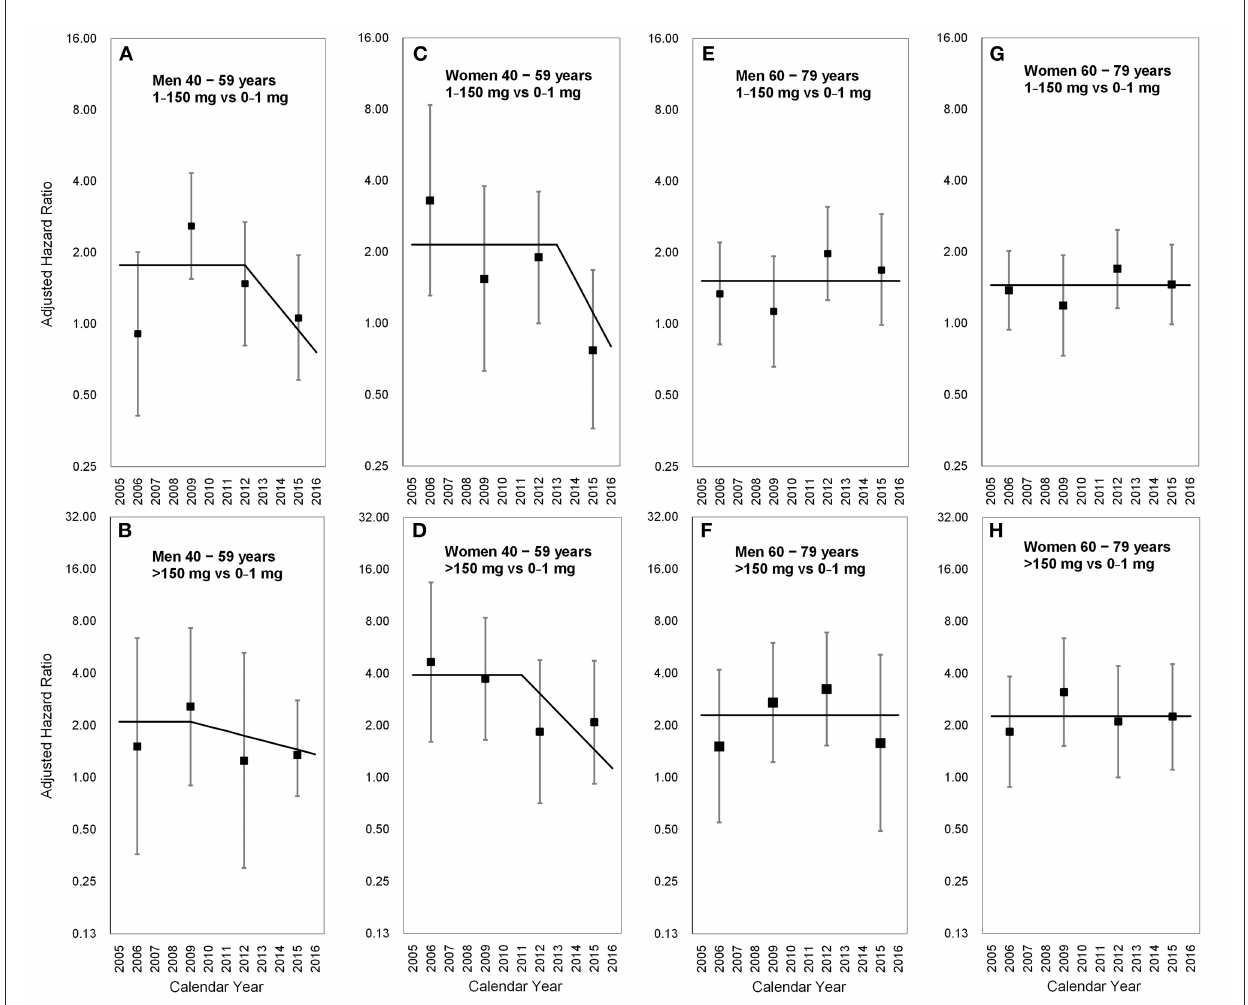
FIGURE3 Long-term trends in the adjusted hazard ratio for upper tract urothelial carcinoma occurrence stratified by sex and age. (A) Men aged 40–59 years; 1–150 vs. 0–1mg, (B) men aged 40–59 years; > 150 vs. 0–1mg, (C) women aged 40–59 years; 1–150 vs. 0–1mg, (D) women aged 40–59 years; > 150 vs. 0–1mg, (E) men aged 60–79 years; 1–150 vs. 0–1mg, (F) men aged 60–79 years; > 150 vs. 0–1mg, (G) women aged 60–79 years; 1–150 vs. 0–1mg, (H) women aged 60–79 years; > 150 vs. 0–1mg. Square points: adjusted hazard ratios from the piecewise constant hazard model. Vertical lines: 95% confidence intervals of the adjusted hazard ratios from the piecewise constant hazard model. Solid lines: adjusted hazard ratios from the slope-change